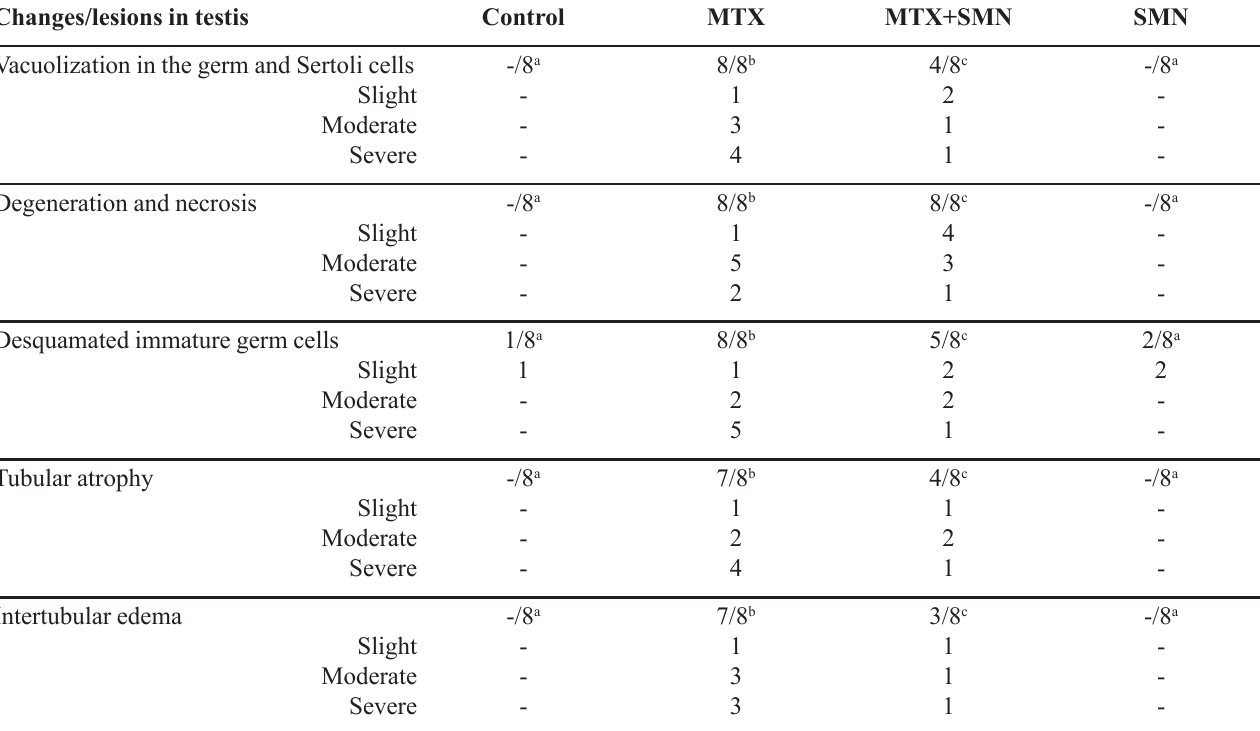
The values present the number of rats showing change/number of rats examined in each treatment group. Values with different letters (a, b and c) in same row are significantly different (P <0.01), according to the Chi-Square